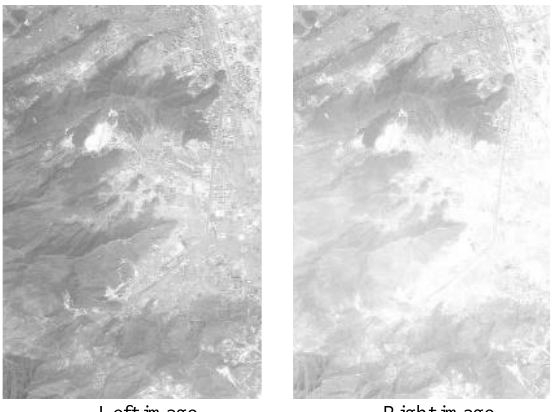
Figure 2. Overview of the IKONOS images